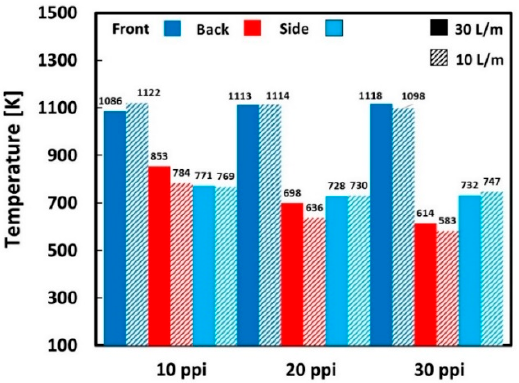
Figure 6. Front, back, and side face temperature data obtained during steady-state operation under different flow rates. Values were averaged over the sensors located in the absorber body.